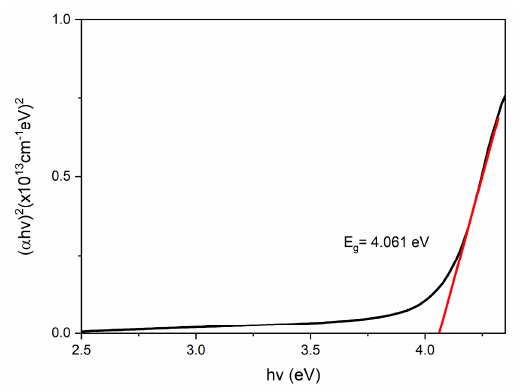
Figure 10. UV-Vis band gap energy of GQDs thin film.